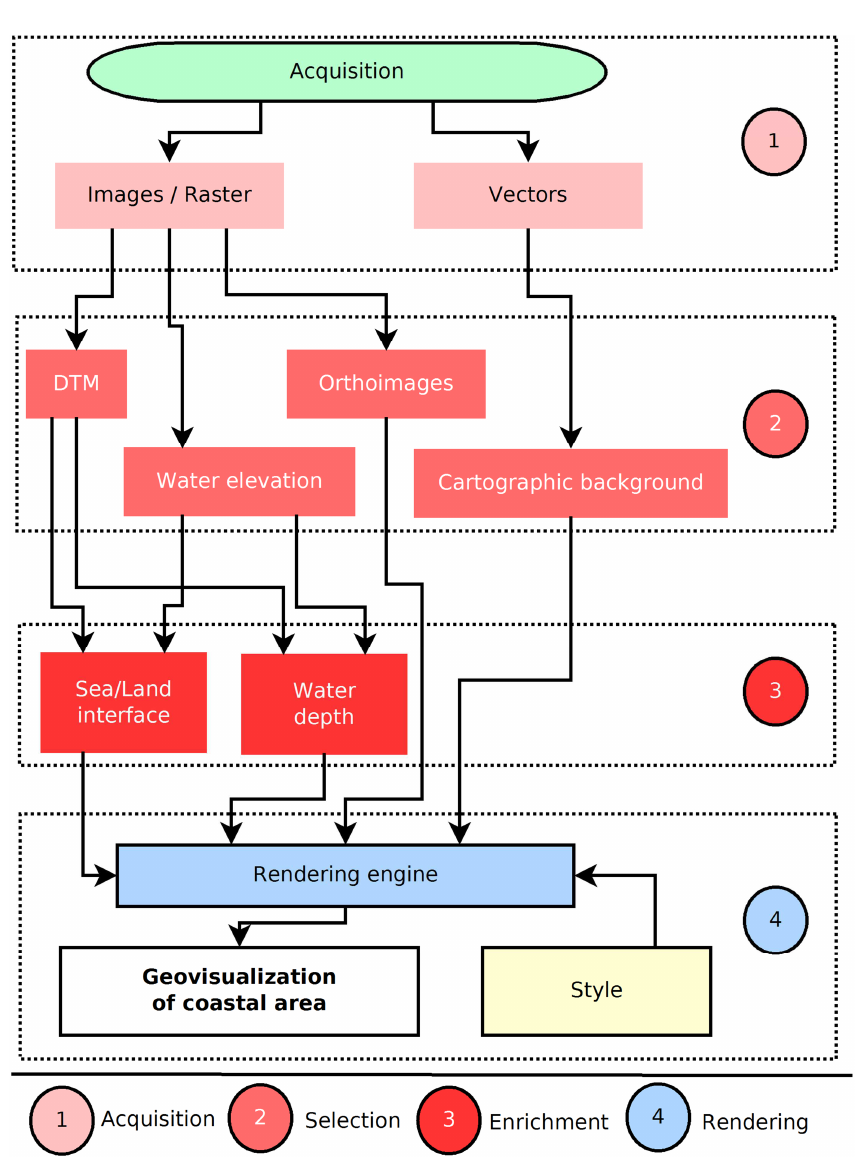
Figure 2: General method for coastal area